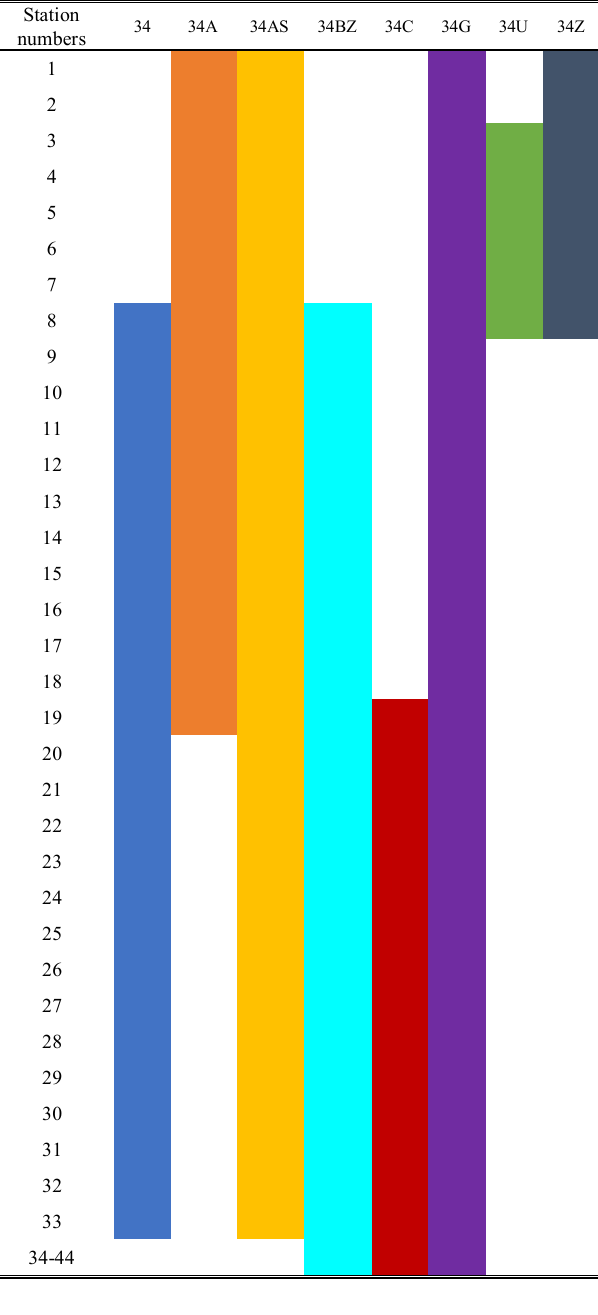
ROUTE FOR EACH METROBUS LINE